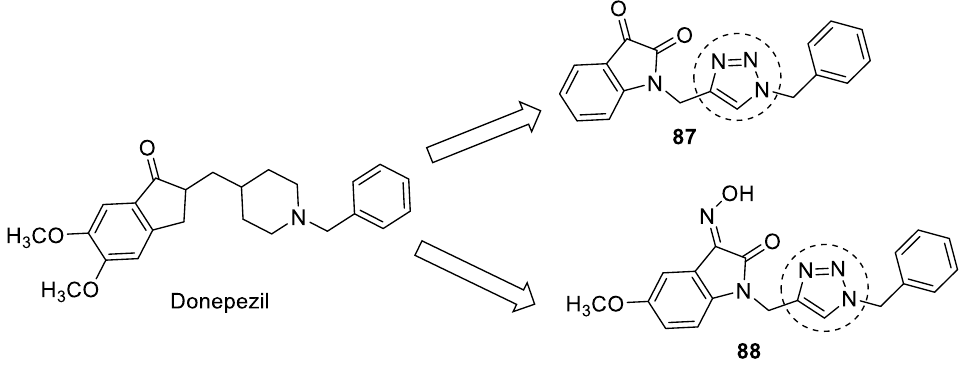
Figure 31. Chemical structure of donepezil – 1,2,3-triazole hybrid.